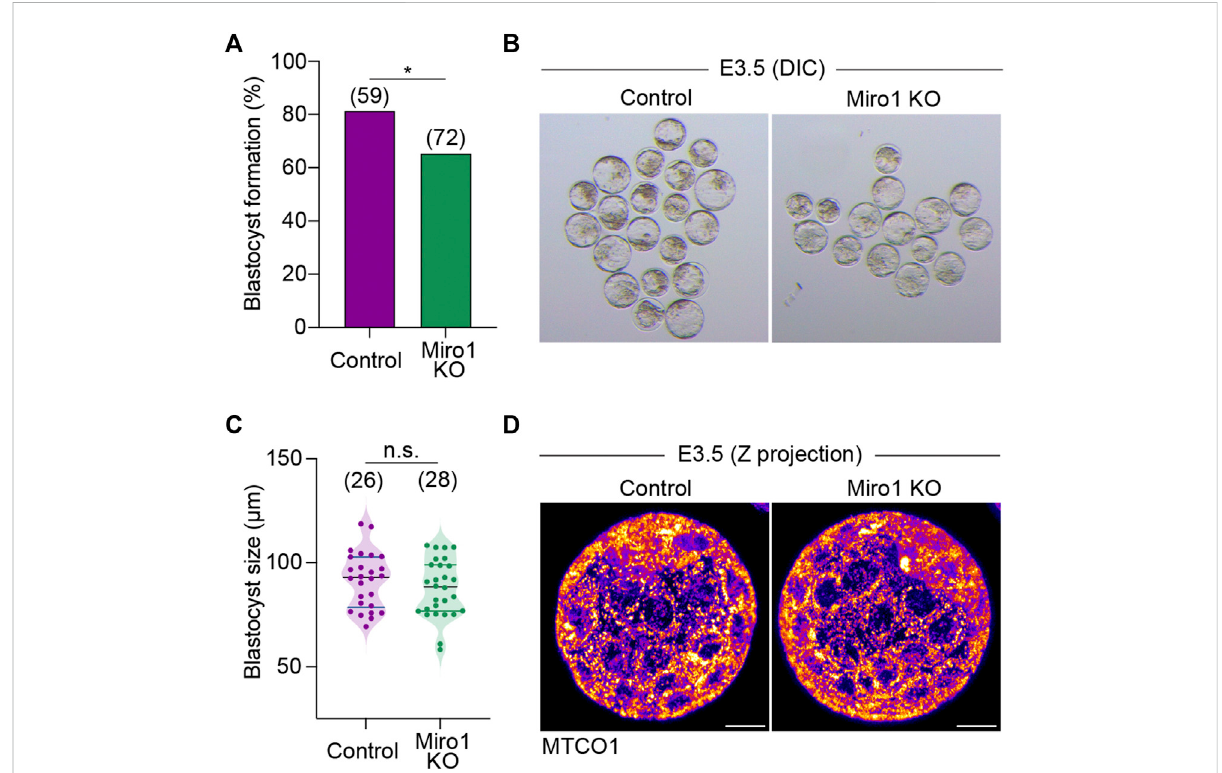
FIGURE 5 Miro1KOparthenotesdeveloptoblastocyst .(A) PercentageofblastocystformationincontrolandMiro1KOparthenotes.Chi-square* p < 0.05. Data are collated from 3 independent experimental replicates. (B) Representative DIC images of control and Miro1 KO parthenotes at E3.5. (C) Measurement of control and Miro1 KO blastocyst size. Unpaired t -test n.s., not signi fi cant. Data are collated from 3 independent experimental replicates. (D) Representative images (maximum z-stack projection) labeled with TMRM in control and Miro1 KO parthenotes at E3.5 (Representative of 26 – 28 parthenotes). Scale bar: 20